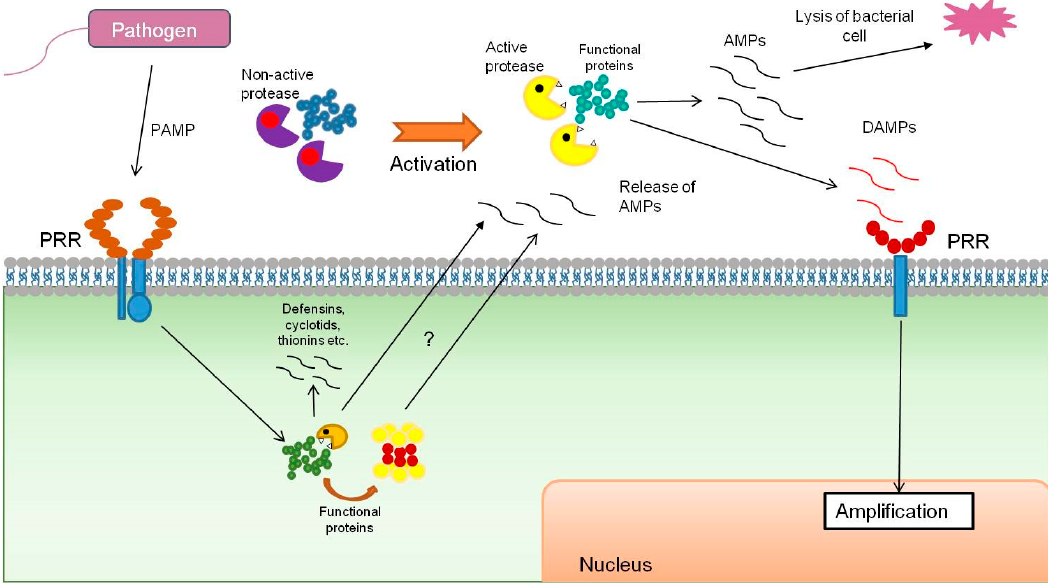
Figure 2. Antimicrobial peptides from functional proteins.